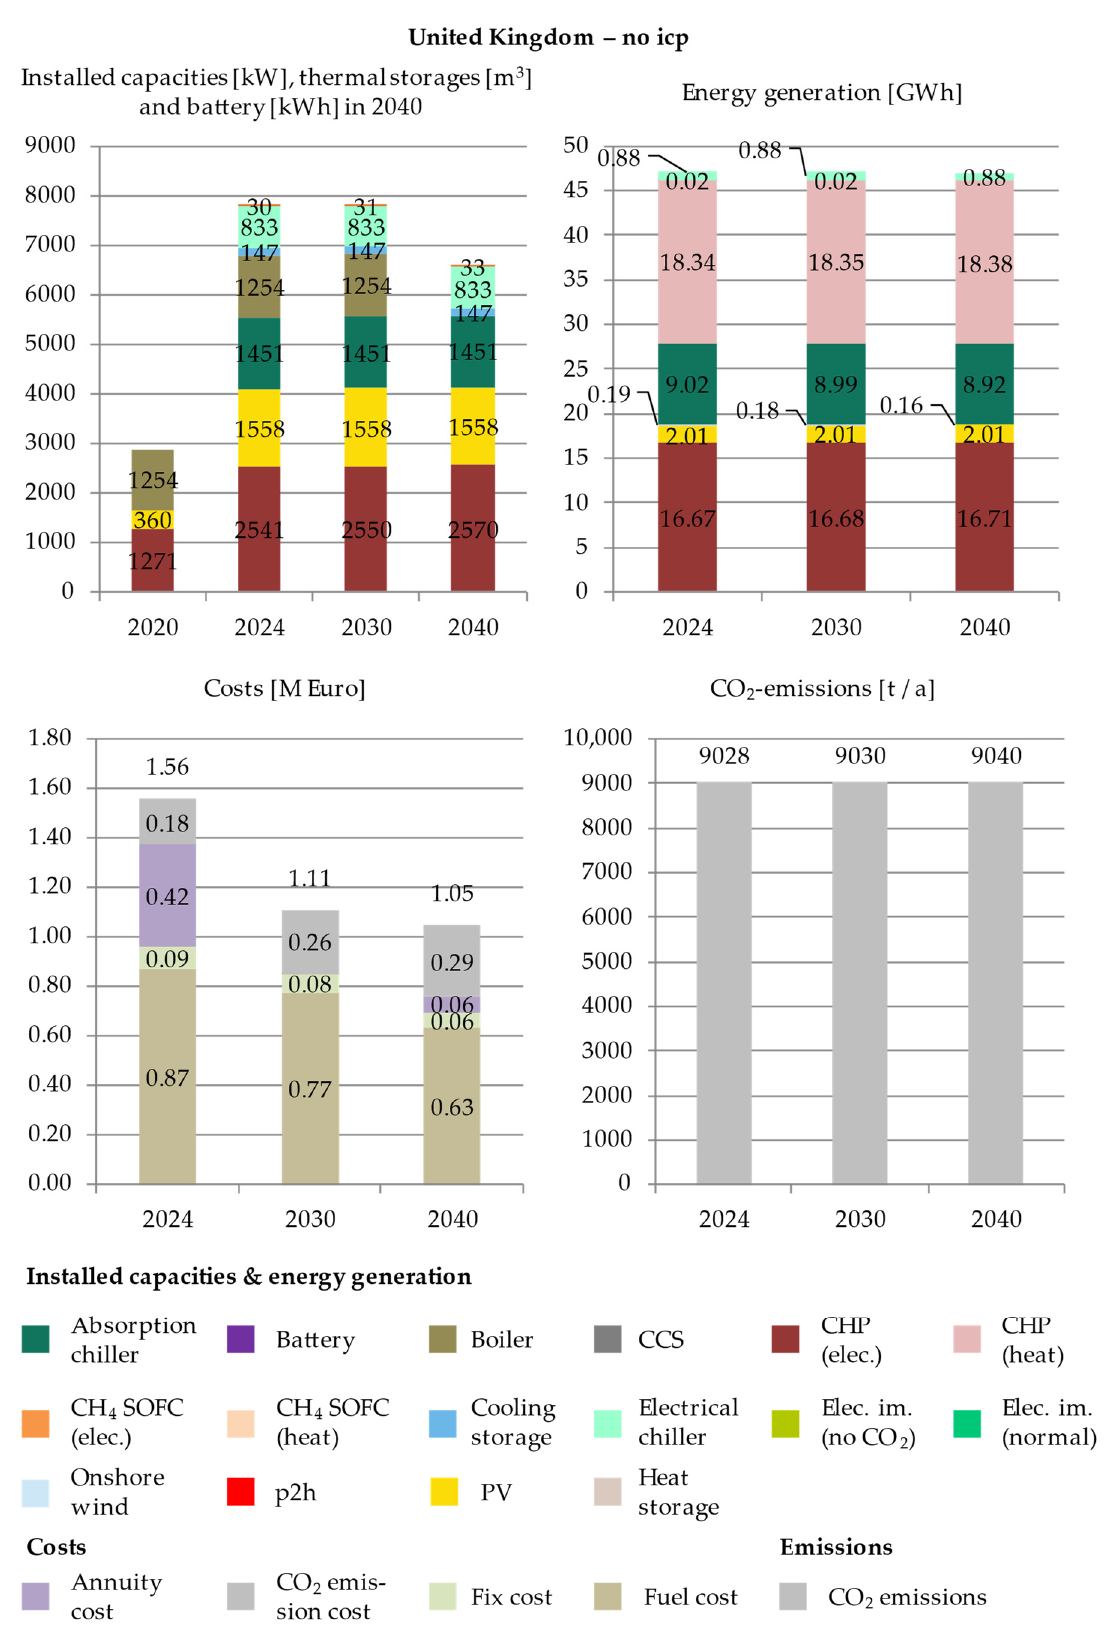
Figure A11. Detailed results for the British “no ICP” scenario.